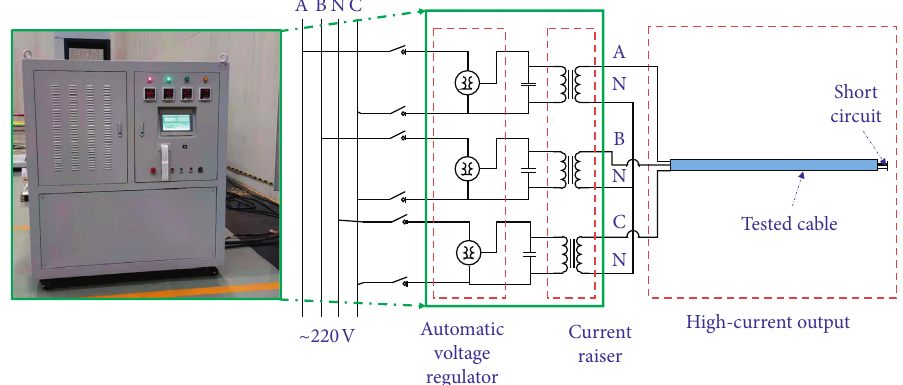
Figure 10: Picture and system diagram of experimental platform. Table 1: Parameters of layers of YJV22 6/10kV cable.